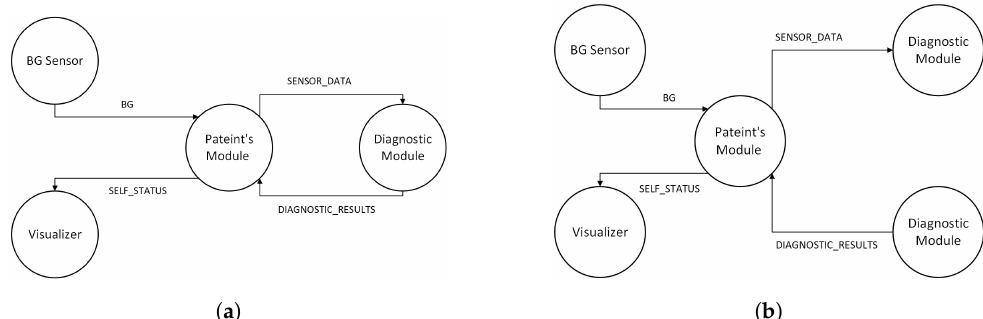
Figure 7. eHealth Application Architecture. ( a ) eHealth Application Architecture used for iFogSim and YAFS. ( b ) eHealth Application Architecture used for LEAF.